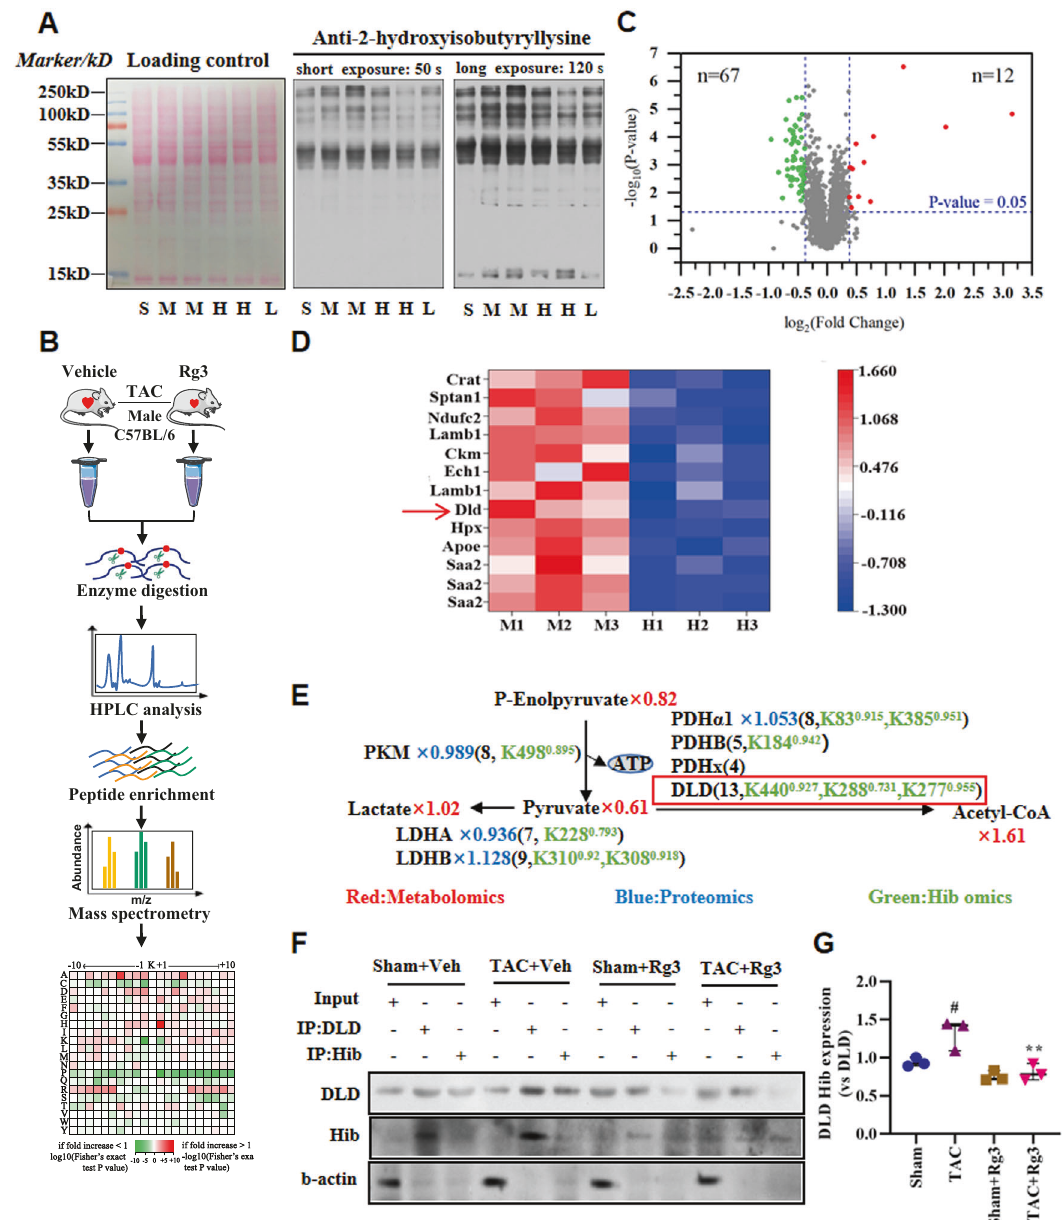
Fig. 2 Protein Lysine 2-Hydroxyisobutyrylation Exerts Changes in the Rg3-treated TAC-Induced Cardiac Hypertrophy. A Western blot of different tissue lysates against anti-2-hydroxyisobutyryllysine antibody, n = 2 – 3 for each group. S: Sham, M: TAC, H: Rg3-20mg/kg group, L: Rg3-10mg/kg group. B The analytical strategy and method for global pro fi ling of Khib on the TAC group and the Rg3-treated group by combining the af fi nity enrichment and proteomics techniques. C Volcano Chart Analysis of the Khib sites for the TAC group and the Rg3- treated group, n = 3 for each group. D The heat map showed the the 10 proteins with the most remarkable down-regulation by 2-hydroxyisobutyrylation. M: TAC, H: Rg3-20mg/kg group. E Reconstruction of glucose metabolism from omics data. The numbers in metabonomics and proteomics represented the change ratio of metabolites or enzymes of Rg3 treated compared with TAC group. F , G Heart homogenates were immunoprecipitated with anti-DLD or anti-2-hydroxyisobutyryl-lysine agarose beads, and probed with anti-2- hydroxyisobutyryl-lysine, anti-DLD, and anti- β -actin antibody. The representative immunoblots were presented, n = 3 for each group. The data were analyzed using Kruskal wallis test, # p < 0.05, ## p < 0.01 versus Sham group, * p < 0.05, ** p < 0.01 versus TAC group. (replacing K by R), and unmodi fi ed states K277, K288, and K440 of The change of 2-hydroxyisobutylation level at K440 is a key DLD by alanine (replacing K by A). We cloned, overexpressed, and point in the regulation of pyruvate metabolism by Rg3 puri fi ed DLD (DLD-K277T, DLD-K277A, DLD-K277R, DLD-K288T, Based on sequence alignment, K277, K288, and K440 of DLD were DLD-K288A, DLD-K288R, DLD-K440T, DLD-K440A, and DLD-K440R) conserved in different species, indicating that K277, K288, and K440 as His-tagged fusion proteins. Surface plasmon resonance technol- might be important for an evolutionarily conserved function ogy was used to explore the effect of changes in the level of (Fig. 3A). Moreover, we locked 2-hydroxyisobutyrylated K277, 2-hydroxyisobutyrylation on the binding ability between Rg3 and K288, and K440 of DLD by threonine (replacing K by T), non-2- DLD. The results showed that the level of 2-hydroxyisobutyrylation hydroxyisobutyrylated K277, K288, and K440 of DLD by arginine Cell Death and Disease (2022)